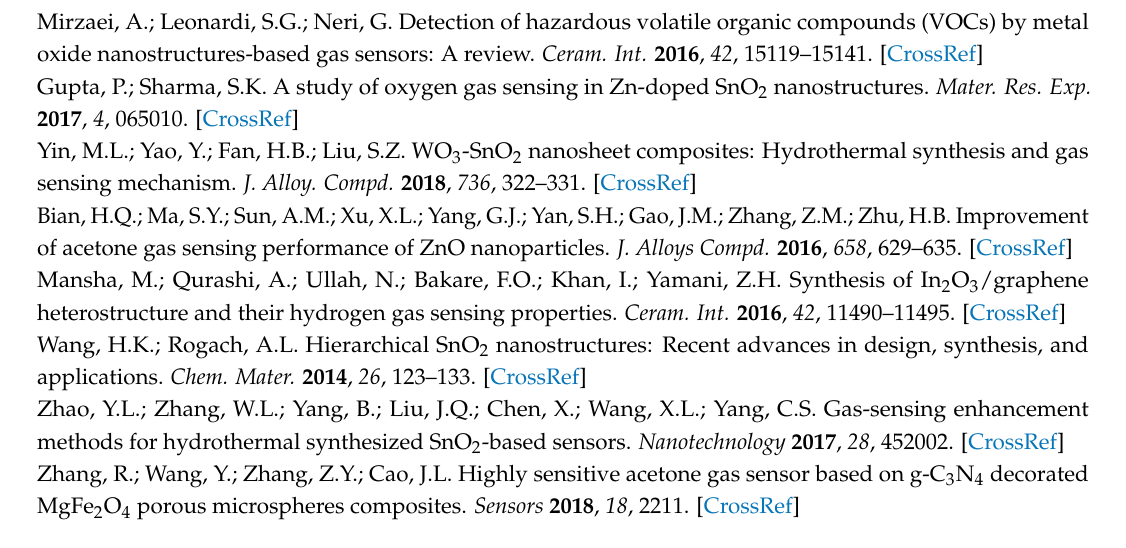
Figure S1: The V-I curve of the N-incorporated SnO 2 sample on Ag electrodes coated Al 2 O 3 substrate at 300 ◦ C; Figure S2: Typical response-recovery current curves of the N-incorporated SnO 2 gas sensor toward acetone gas with different concentration at different temperatures: (a) 250 ◦ C; (b) 350 ◦ C; (c) 400 ◦ C; Figure S3: The response and recovery curve for the N-incorporated SnO 2 sample toward 1 ppm of acetone at 200 ◦ C; Figure S4: Stability response curve of the N-incorporated SnO 2 gas sensor toward 100 ppm of acetone at 300 ◦ C. Table S1: The repeatability within a batch of three